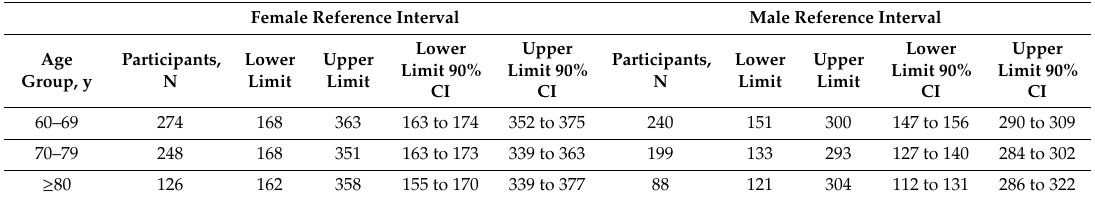
Table 2. Direct reference intervals for platelet counts stratified according to age and sex. Collapsed reference interval for females without age stratification is 167 (90% CI (164, 170)) to 355 (90% CI (347, 362)). CI, confidence interval.